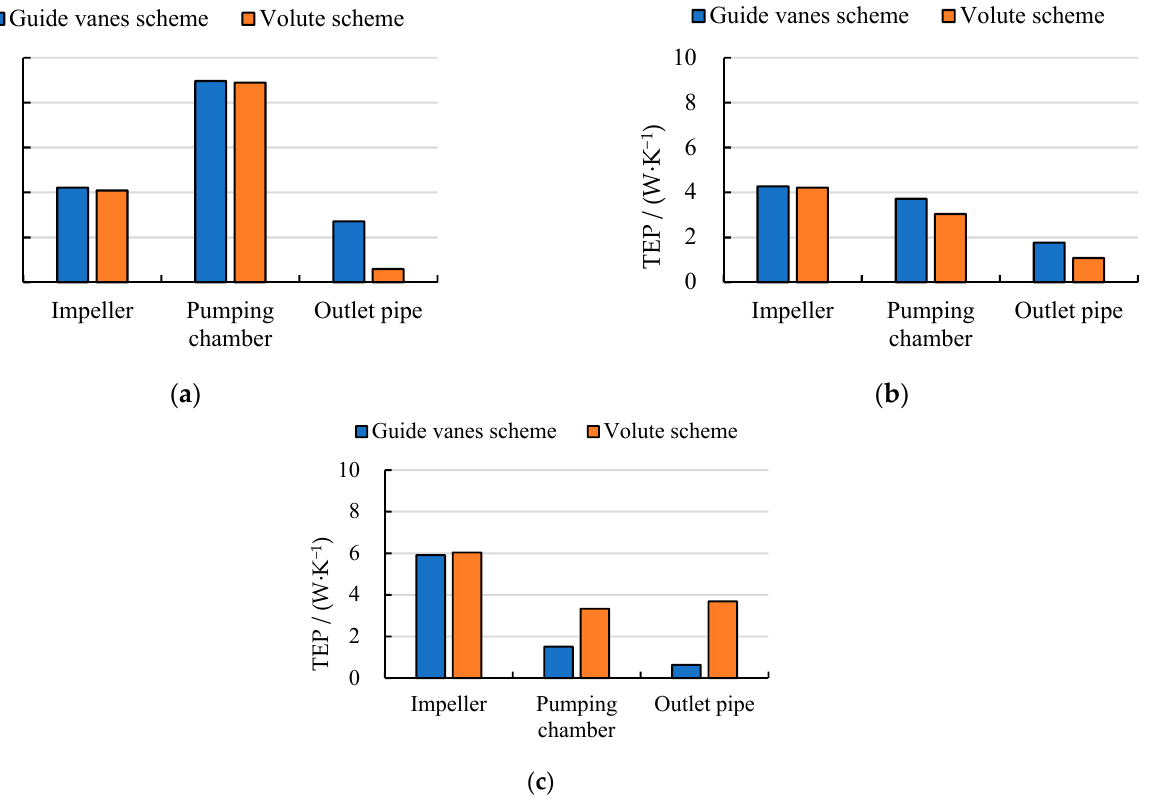
( b ) Figure 8. The distribution of ( a ) IEP and ( b ) DEP in the mixed-flow pump with a volute . Figure 9 shows a comparison of the TEP between the mixed-flow pump with guide vanes and a volute under three flow rates. Since the inlet pipe was located upstream of the pumping chamber and impeller, the TEP of the inlet pipe was low and not affected by the type of pumping chamber. Although the impeller was also located upstream of the pumping chamber, the TEP of impeller were different in two types of mixed-flow pump